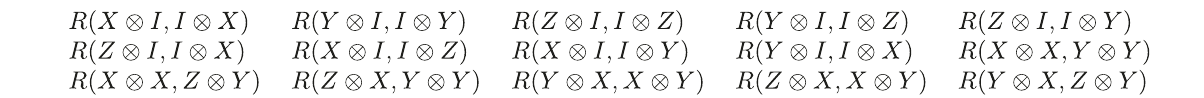
Fig. 1 The 15 elements of S . These operators are one suitable choice for 15 RðP ; QÞ gates which are not equivalent to each other up to right-multiplication by Cliffords. All other choices are equivalent to this one up to right-multiplication by Cliffords. The ordering of S is given by reading left-to-right and